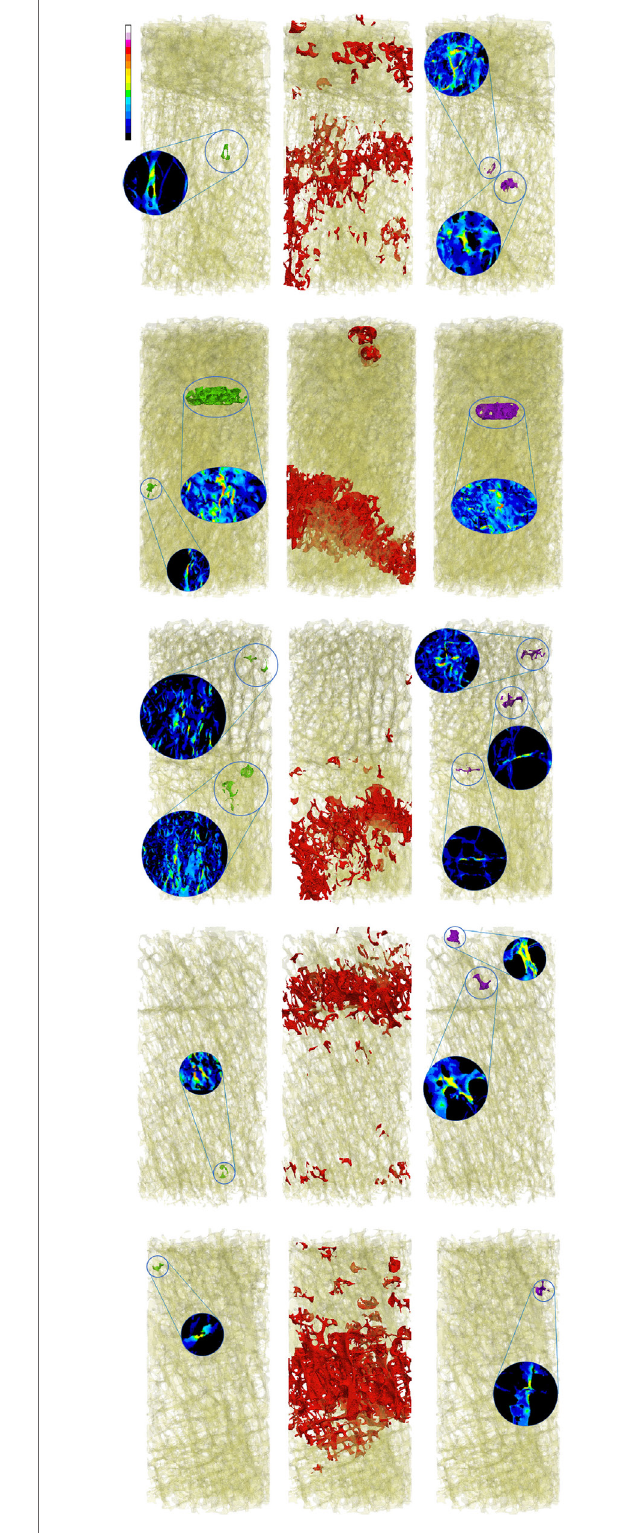
FigUre 3 | Zones of maximum compression (left), fracture (center), and maximum tension (right) are reported in comparison to the fracture zone (center) for the five high fracture volume